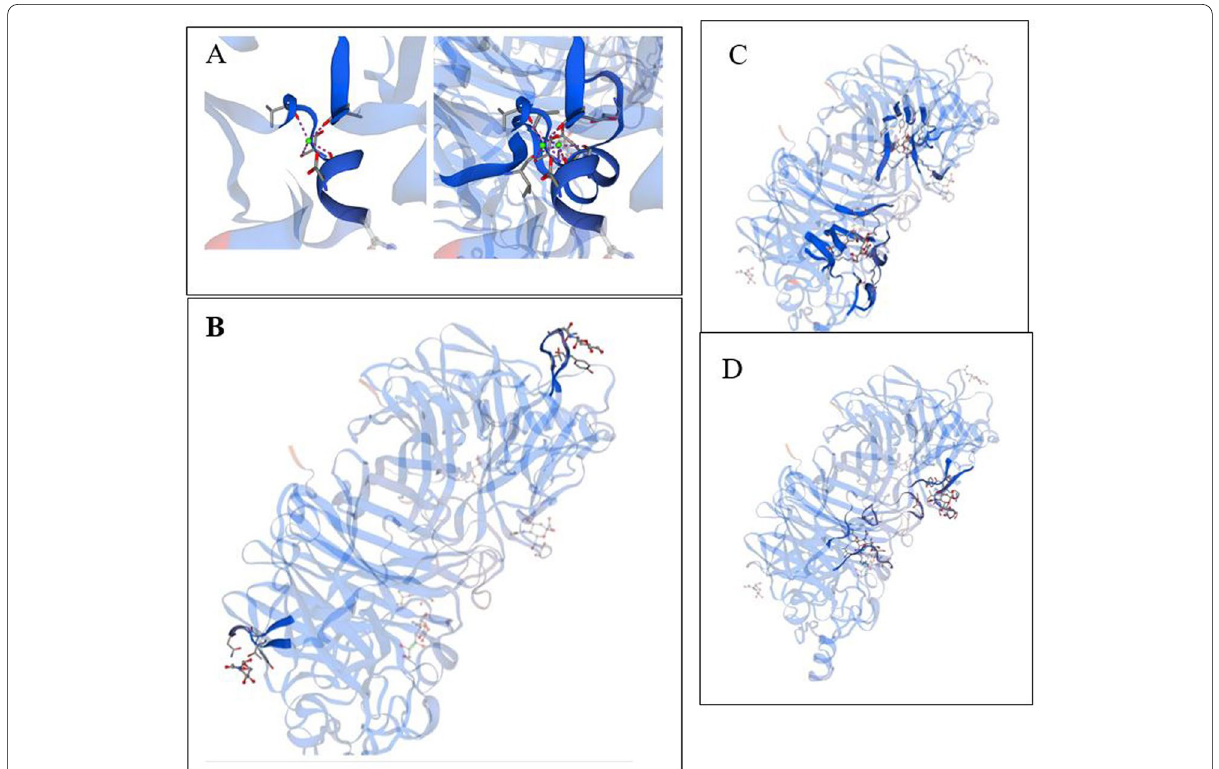
Fig. 4 Evaluation of the protein structure in terms of calcium ion position, 2-deoxy-2,3-dehydro- N -acetyl-neuraminic acid and sugar. A Residuesof calcium ions, atomic arrangement and interaction. B Residuesof 2-deoxy-2,3-dehydro- N -acetyl-neuraminic acid, atomic arrangement and interaction. C Residuesof 2-(acetylamino)-2-deoxy- A - d -glucopyranose, atomic arrangement and interaction. D Residuesof O-sialic acid, atomic arrangement and